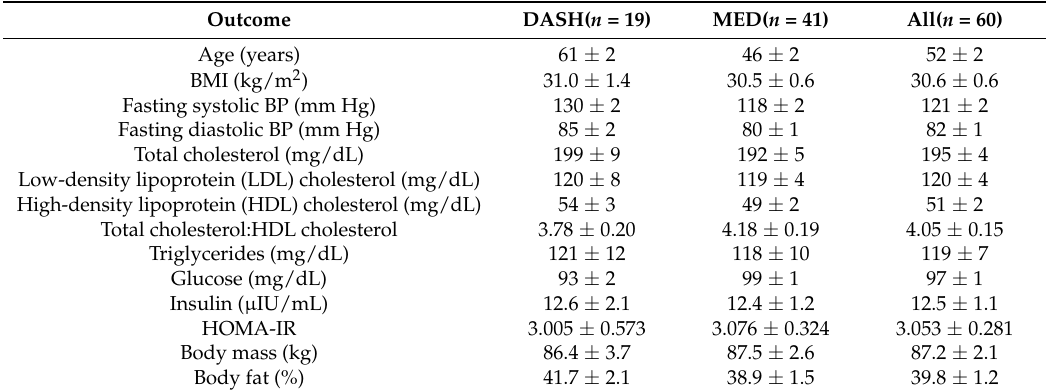
Table 2. Subject baseline 1 fasting cardiovascular health